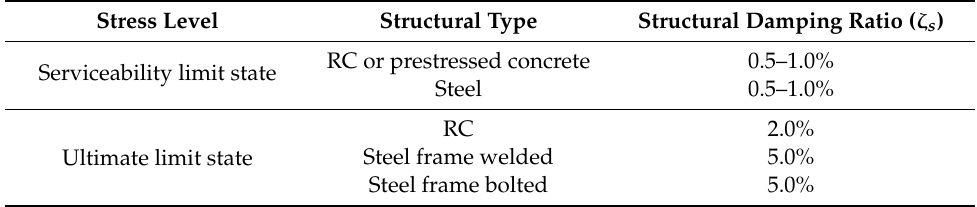
Table 3. Values of damping ratio in the Australia and New Zealand standard (AS / NZS